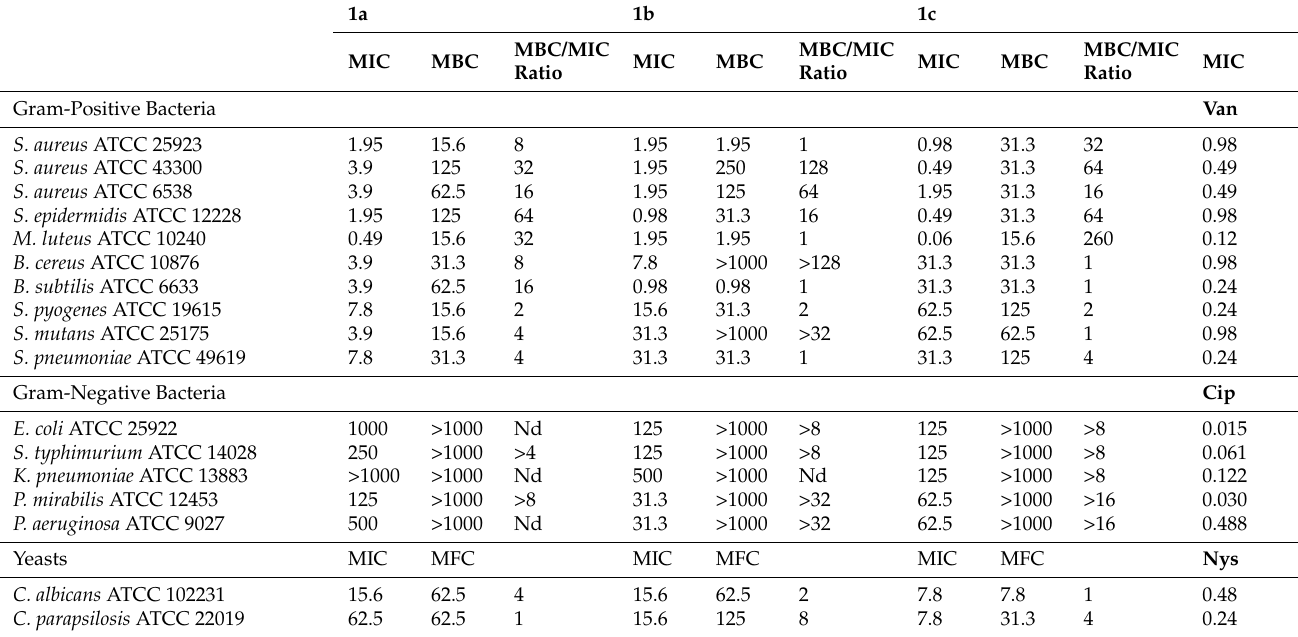
In vitro antimicrobial activity of compounds 1a – c against reference bacterial and fungal strains 1,2,3